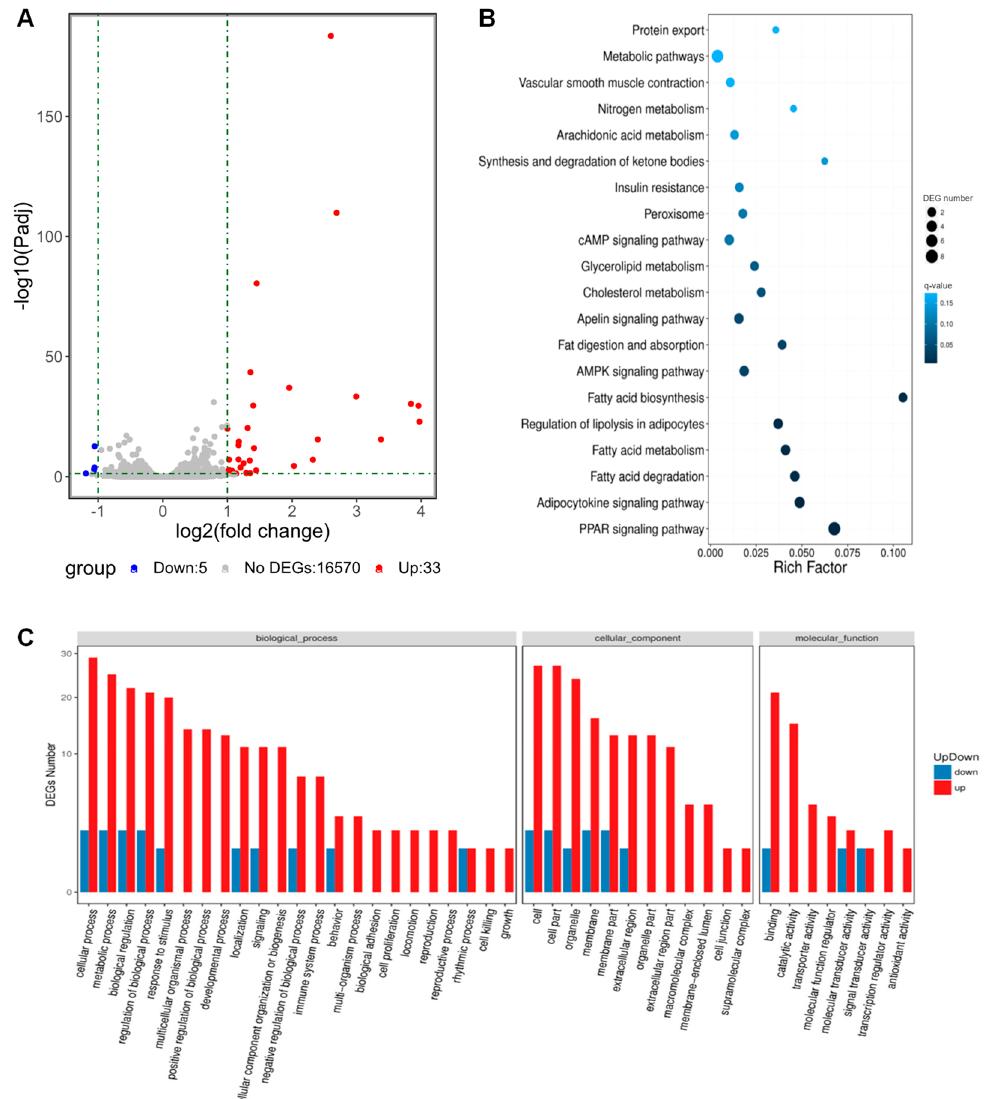
Figure 6. RNA-seq of 3T3-L1 preadipocytes treated with recombinant CHRDL1 protein. ( A ) Volcano plot of differentially expressed genes (DEGs) between treated samples (with recombinant CHRDL1 protein, 100 ng/mL) and untreated controls. Sequencing was performed in triplicates. The x -axis represents log2 transformed fold change. The y -axis represents − log10 transformed adjusted p -value ( P adj), and the larger values indicate more significance. DEGs passed a threshold of |fold change| > 2 and P adj < 0.05 (green dash-dotted lines). Up, up-regulated DEGs in treated samples; Down, down-regulated DEGs in treated samples; NoDEGs, genes that are not differentially expressed. ( B ) Enriched KEGG pathways. The color indicates the q -value, and the lower q -value (darker) indicates the more significant enrichment. The point size indicates DEG numbers. Rich Factor is a value of enrichment factor which is obtained by dividing the number of DEGs by the total number of genes in the corresponding pathway. The larger the Rich Factor, the more the significant enrichment. ( C ) Gene Ontology (GO) enrichment analysis. The x -axis represents the most enriched GO terms in the categories of biological processes, cellular components, and molecular functions. The y -axis represents the number of up- or down-regulated